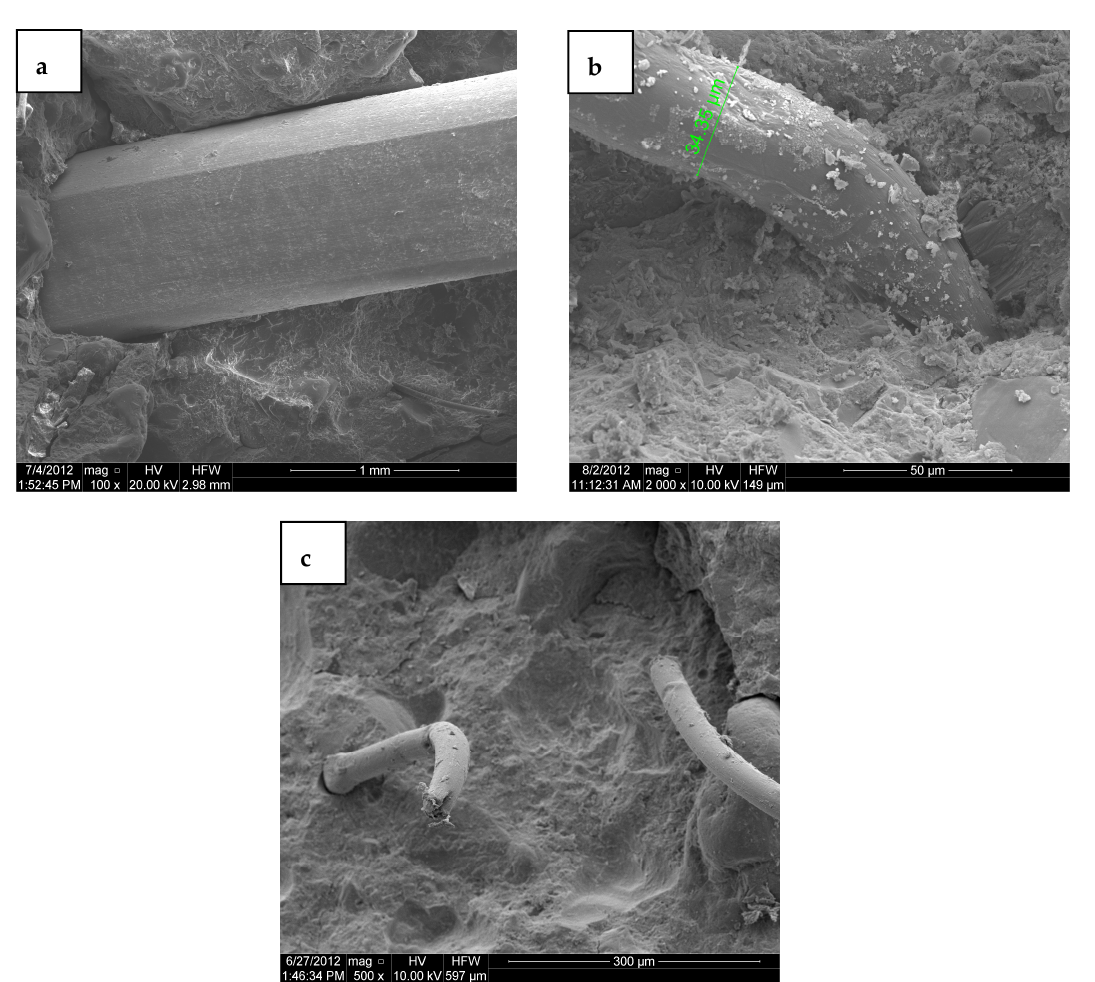
Figure 5. Scanning electron microscope (SEM) images of ( a ) steel fibre; ( b ) polypropylene (PP) fibre in the HFRHPC matrix; ( c ) rupture of PP fibre.